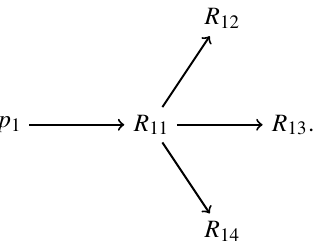
and enters into the subregion R 12 , or crosses the boundary g = 0 and goes to the subregion R 13 , or crosses the inter- section curve of the subregions R 11 , R 12 and R 13 into the subregion R 14 with very low probability, i.e. an orbit in the subregion R 11 will not stay in the future in this region, but will exit through its boundaries into other subregions, and